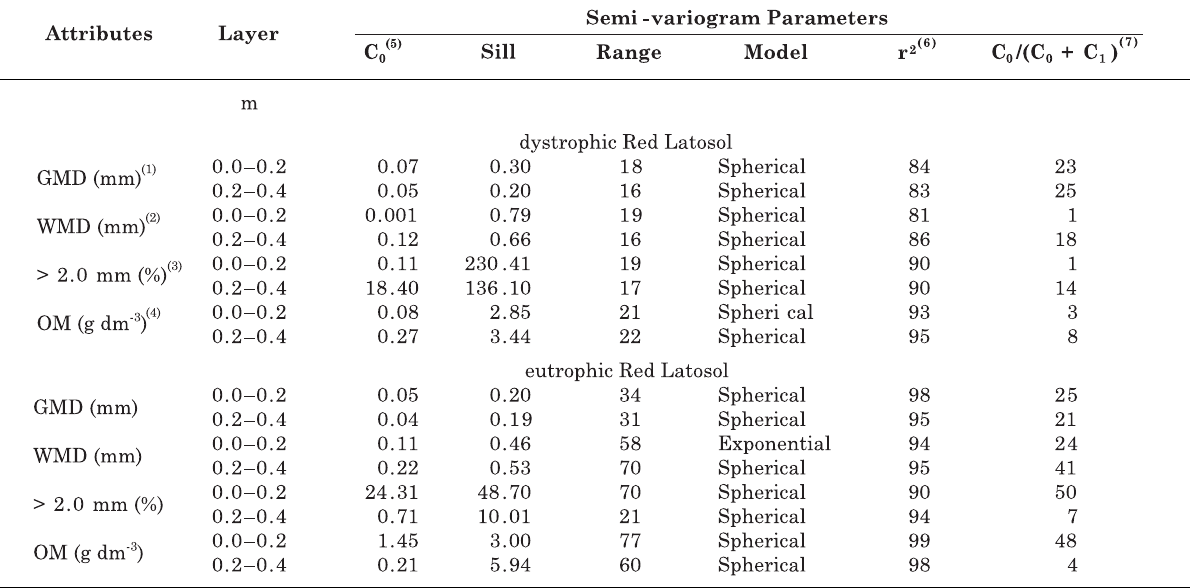
Table 2. Estimated models and parameters for experimental semi-variograms for the variables geometric mean diameter, mean weight diameter, aggregates in class > 2.0 mm and organic matter proportion, in an eutrophic Red Latosol and a dystrophic Red Latosol in the soil layers 0.0–0.2 and 0.2–0.4